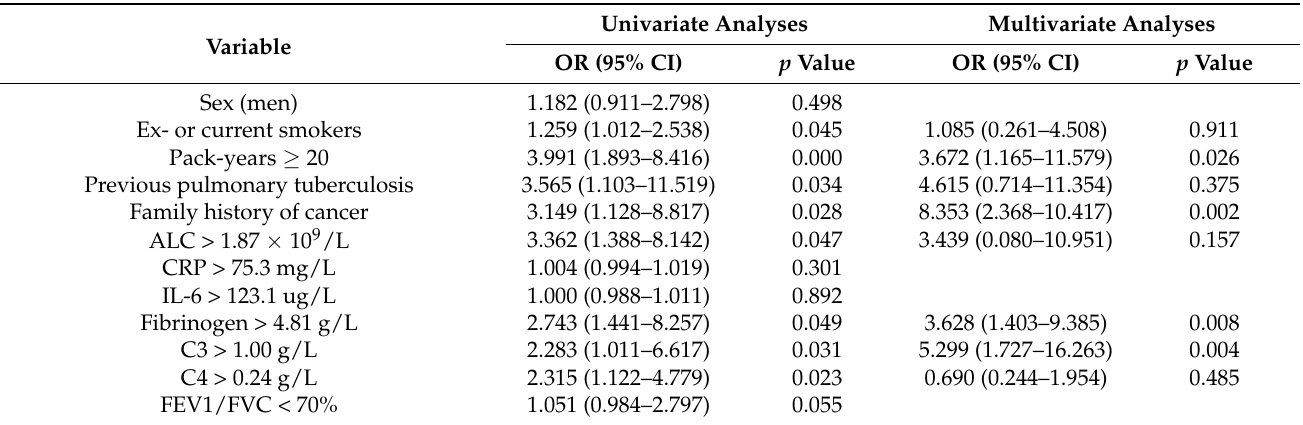
Table 3. Univariate and multivariate analyses of independent factors for the presence of LC in patients with CPFE.